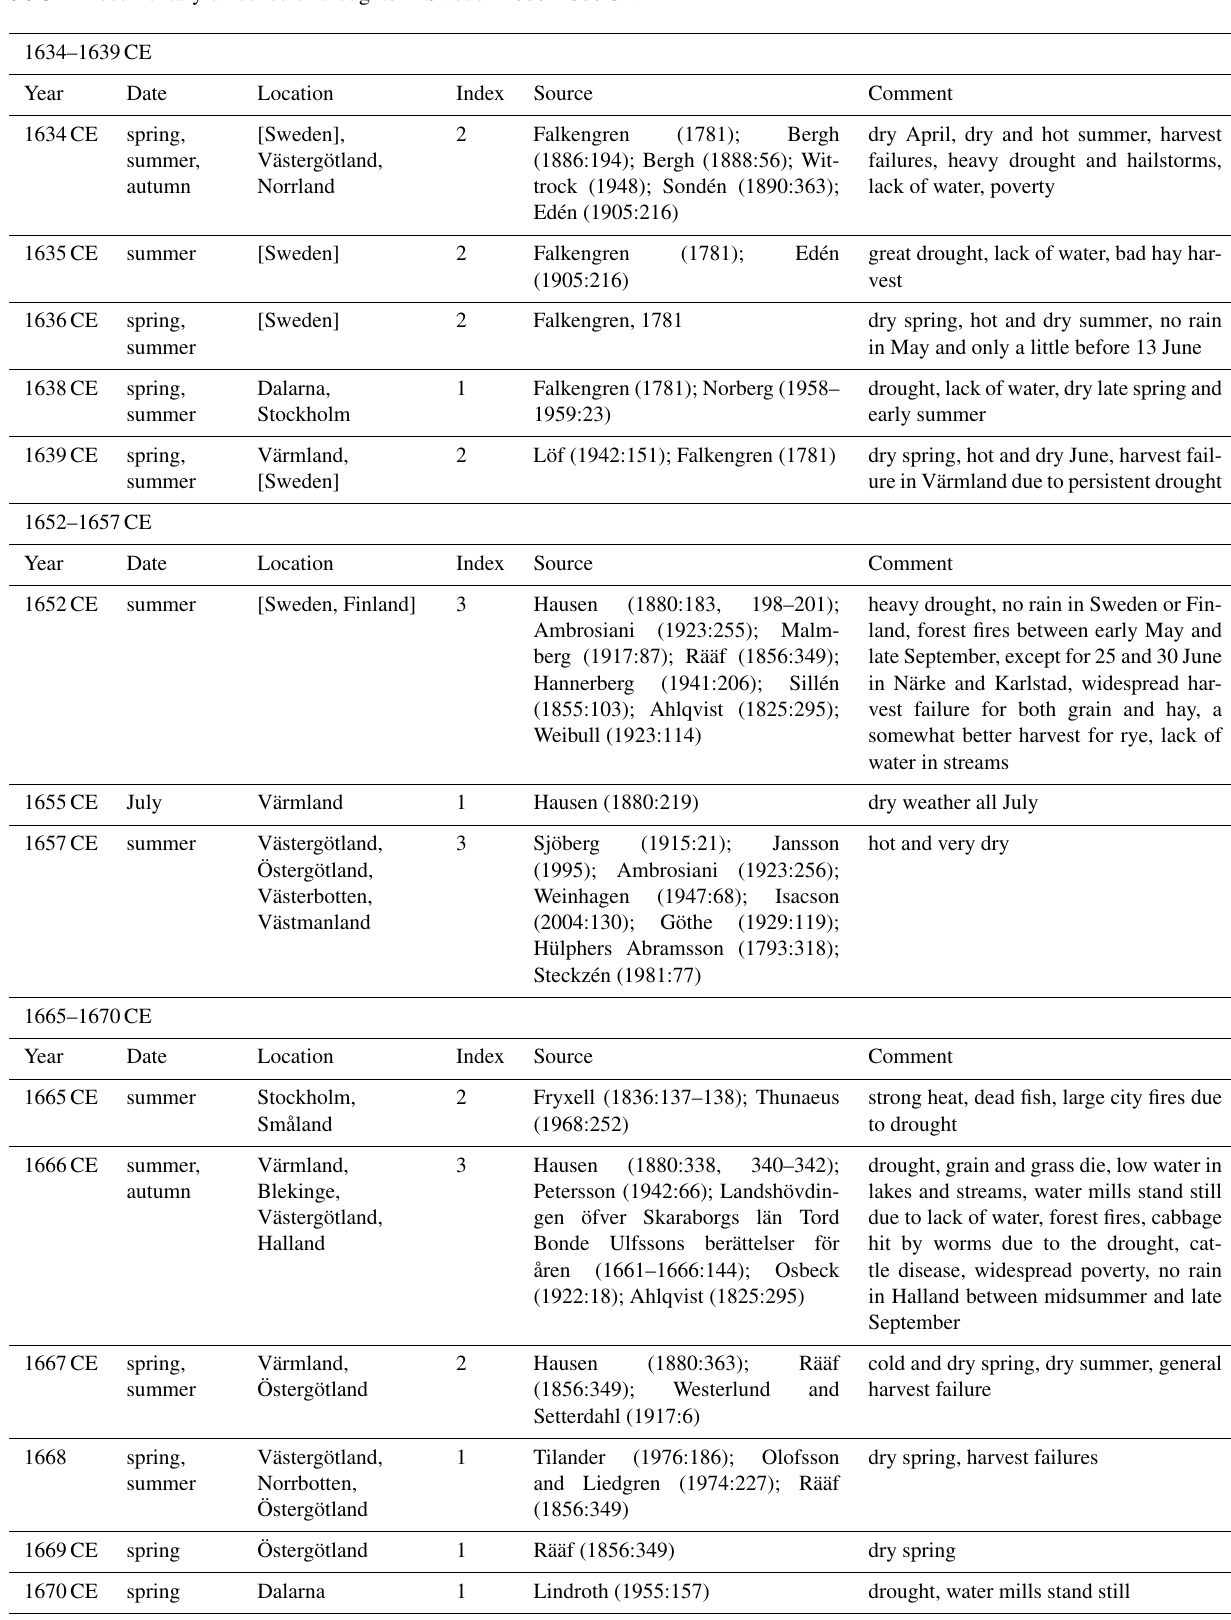
Table 4. Documentary evidence of droughts in Sweden